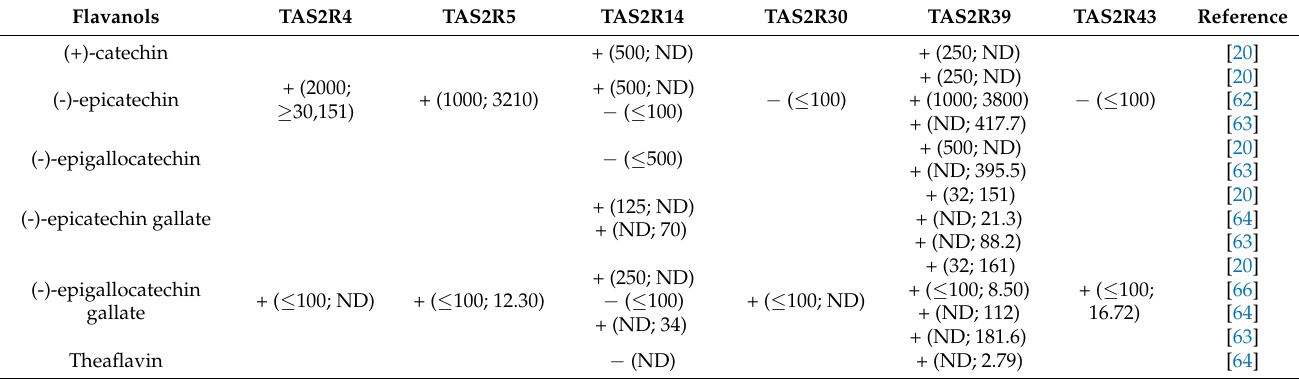
Table 4. TAS2Rs activated by some flavanols identified in pulses (adzuki beans, beans *, chickpeas, faba beans, lentils and